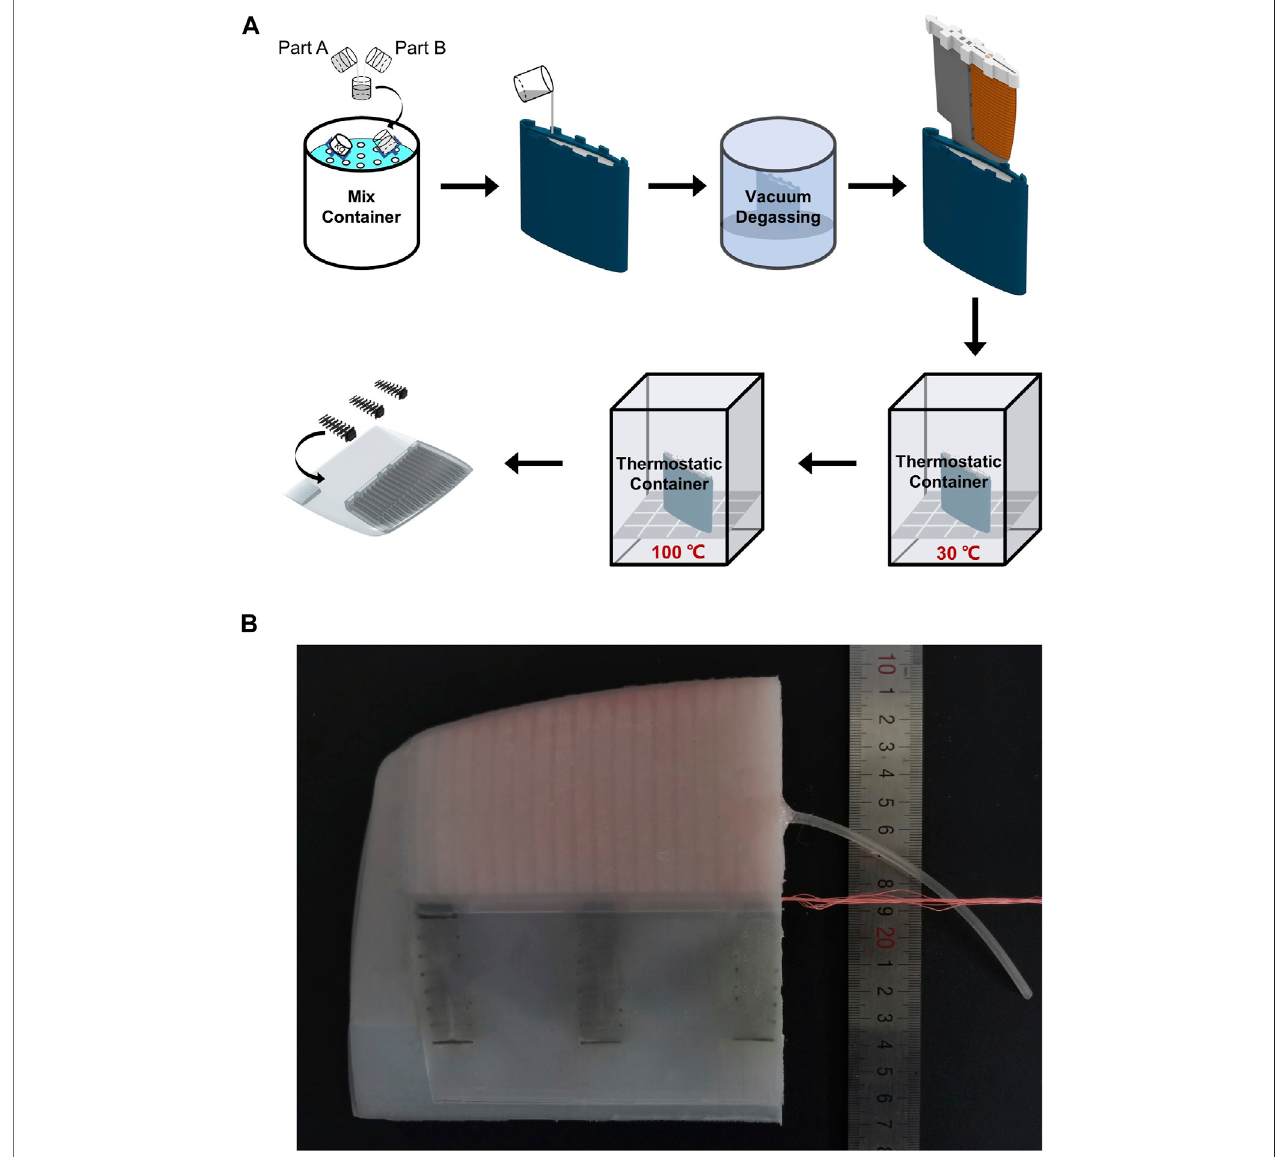
FIGURE 2 | (A) Molding process of spar and skin; (B) A fabricated prototype of the morphing wing.